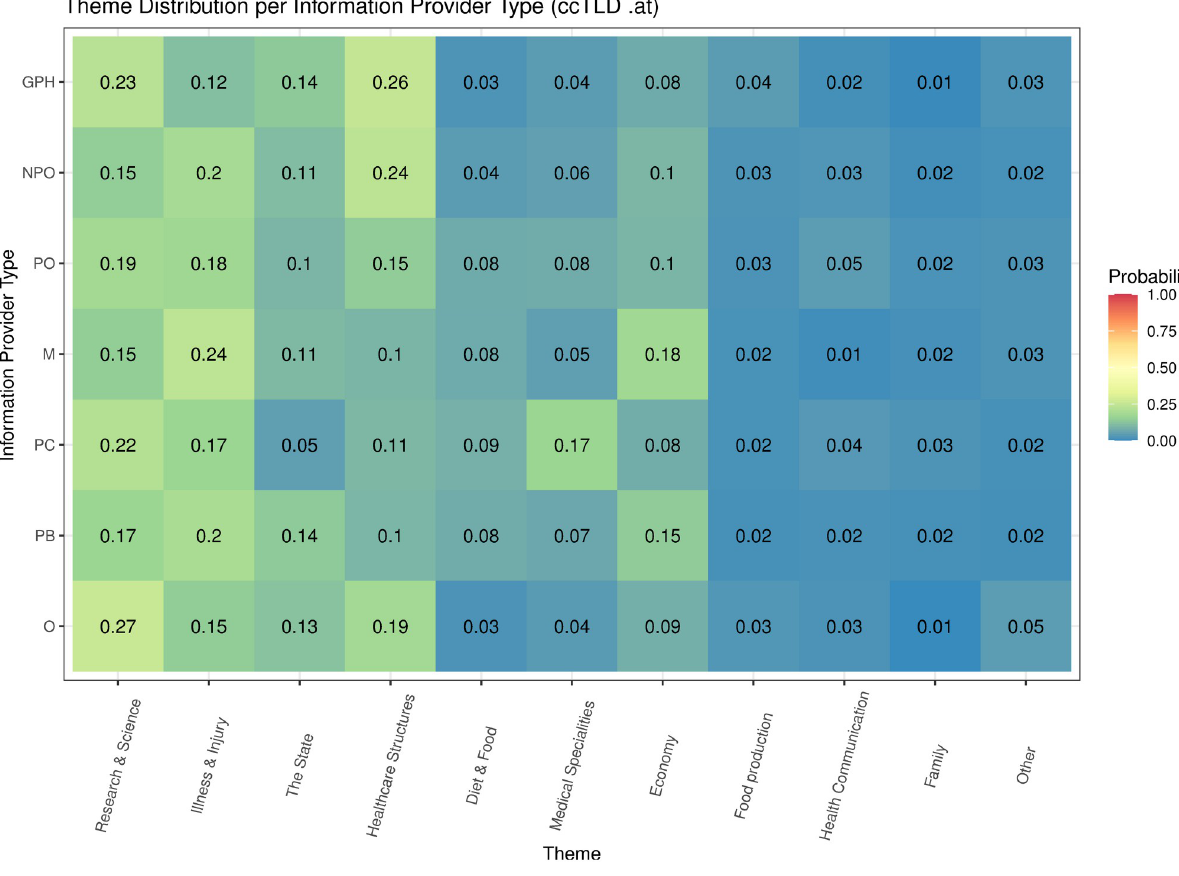
Fig 10. Theme distribution per information provider type for the ccTLD “.at”. Information provider types: GPH: Government, Public Institution or Public Health, NPO: Non-Profit Organization, PO: Private Organization, M: Mainstream or Local News, PC: Pharmaceutical Company, PB: Private Blog, Other: